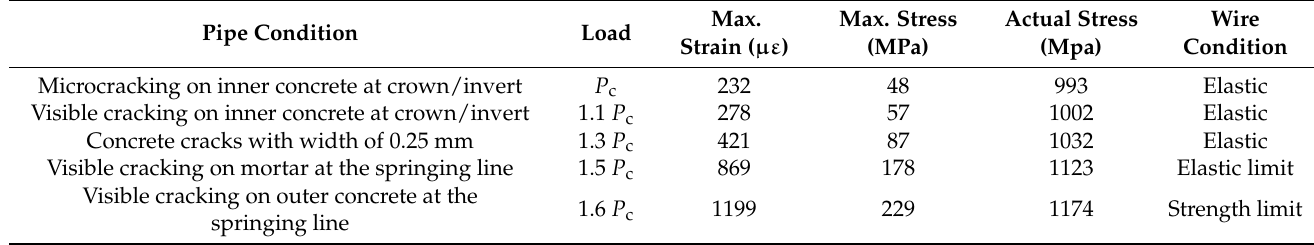
Table 8. Stress state of prestressed steel wire at the springing line at different stages.